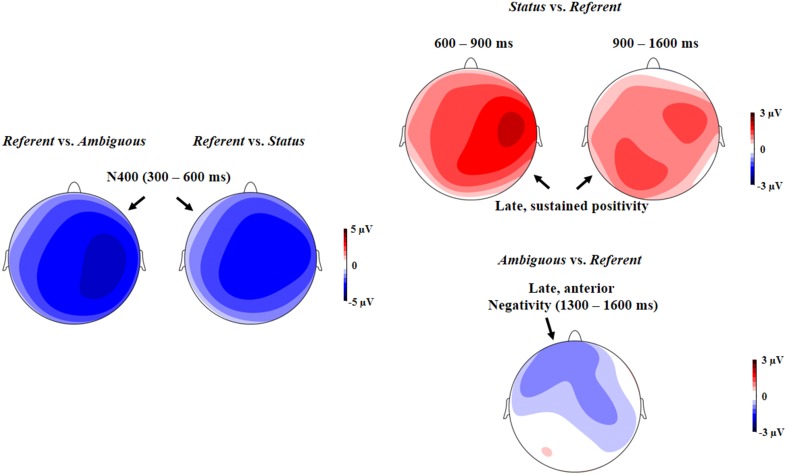
Topographic maps showing the ERP differences from 300 to 600 ms (N400) between the Referent and the Status and between the Referent and the Ambiguous conditions (the left panel), the ERP differences between the Status and the Referent conditions in the time windows from 600 to 900 ms and from 900 to 1600 ms (the middle panels), and the ERP differences between the Ambiguous and the Referent conditions from 1300 to 1600 ms (the right panel).